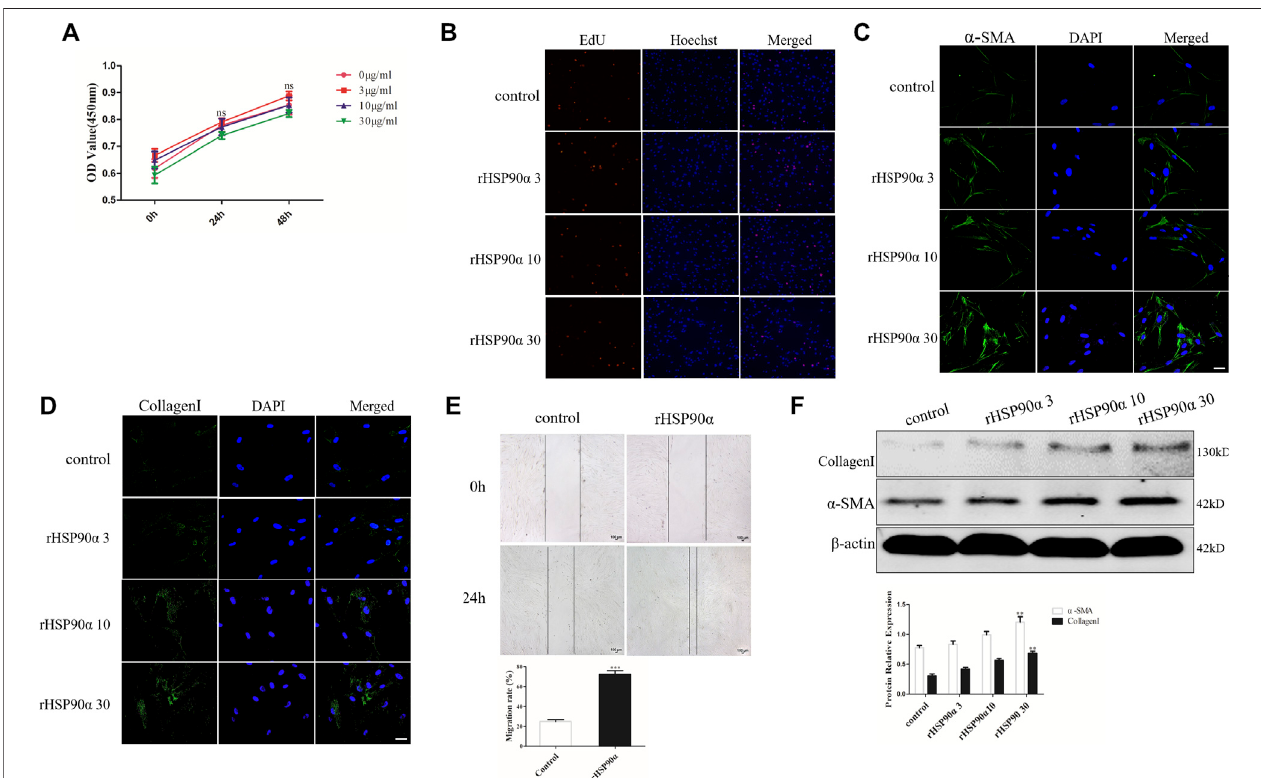
FIGURE1| ExtracellularHSP90 α promoteslung fi broblastsactivationbuthasnoin fl uenceonproliferation. (A) .Cellproliferationwasassessed via theCCK8assay afterstimulationwith0,3,10and30 ug/mlrHSP90 α forindicatedtimes(24and48 h)intheIMR90cells. (B) .ProliferativecapacitywasanalyzedusinganEdUassayafter treatment with 0, 3, 10 and 30 ug/ml rHSP90 α in the IMR90 cells for 24 h. Lung fi broblasts activation was assessed by immuno fl uorescence staining for α -SMA and CollagenI (C,D) , representative staining images of α -SMA – positive stress fi bers (green), CollagenI-positive collagen deposition (green) and DAPI (blue) showing nucleiunderconfocallaserscanningmicroscopy(scalebar (cid:1) 50 μ m). (E) .Fibroblastsmigrationwereperformedbywound-healingassays. (F) .Theproteinexpressionof CollagenI and α -SMAweredetermined by western blot after stimulation ofdifferent concentrationsof rHSP90 α for 24 h, β -actin wasused asan internal control. ns (cid:1) no signi fi cance, * p < 0.05, ** p <